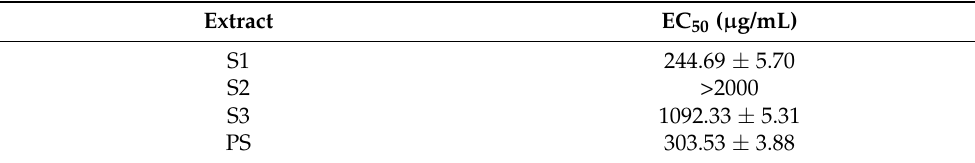
Table 4. Cellular antioxidant activity of SFE extracts from MB.